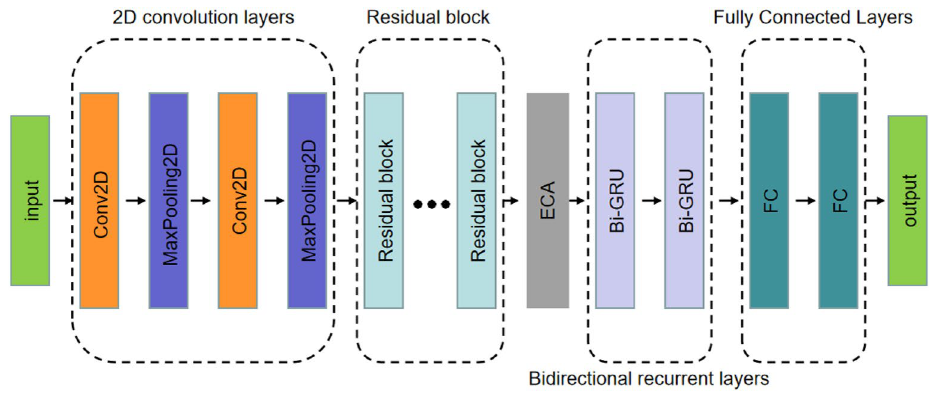
Figure 1. The architecture of the proposed method.